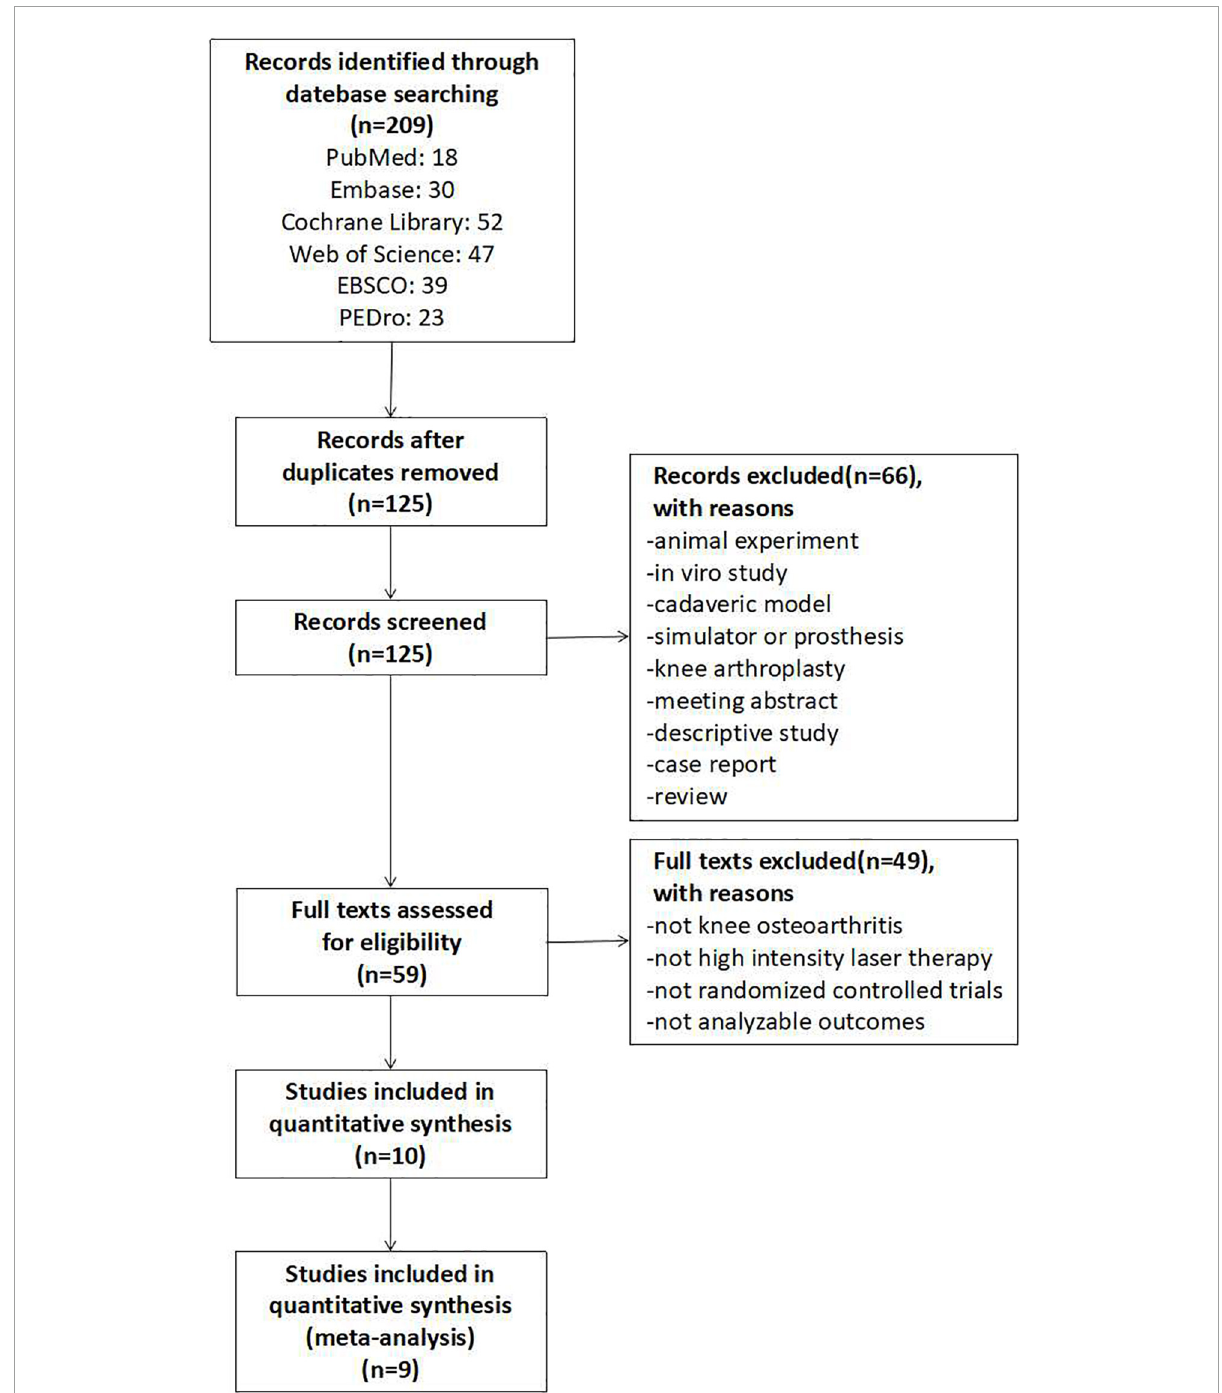
FIGURE1 Flowchart of study selection.